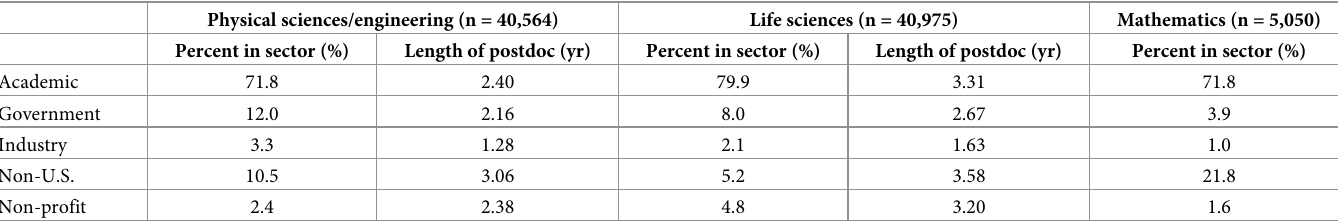
Table 2. Percentage of postdocs and estimated length of postdoc by field and employment sector from 2009 to 2018.